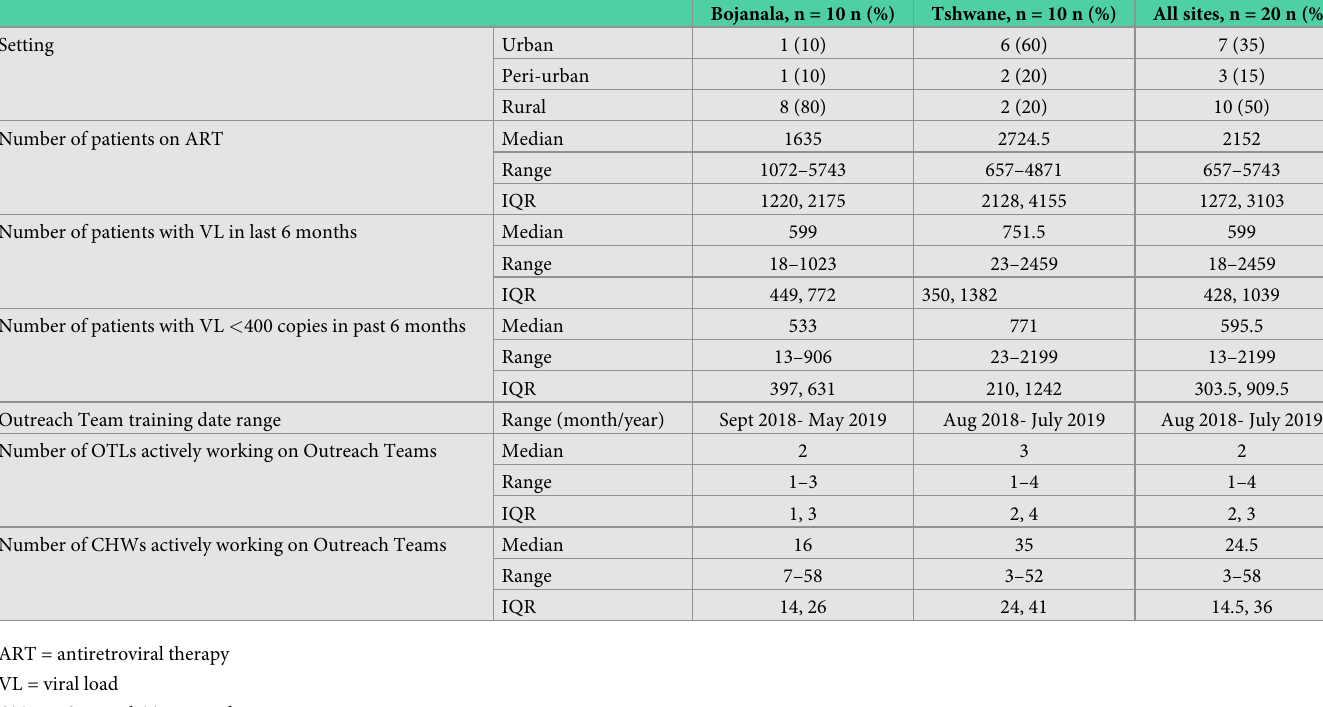
Table 1. Site characteristics of the 20 evaluation facilities, September-November 2019.